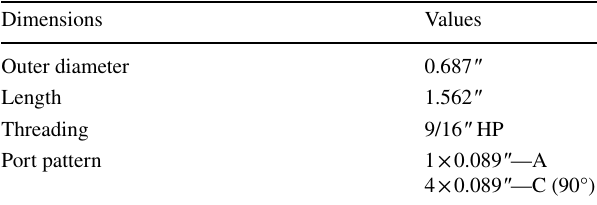
Table 1 Dimensions of the selected catalogue nozzle (Gardner